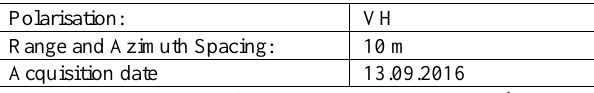
Table 1. Properties of SENTINEL-1A SAR image (ESA,